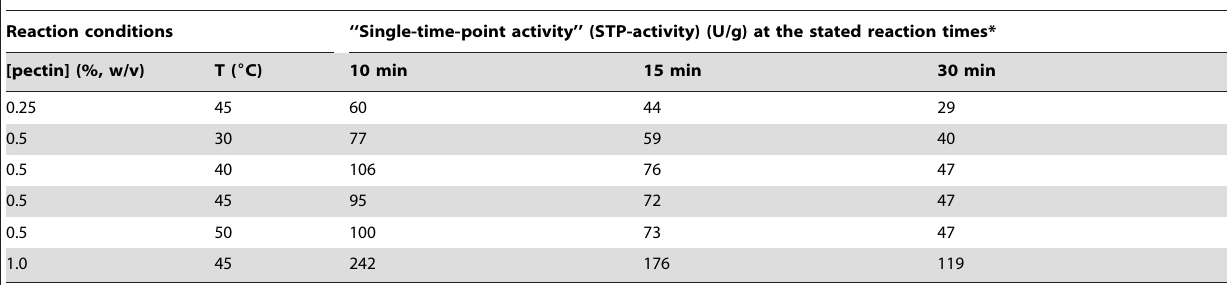
Table 3. Single-time-point pectinase activities that would be obtained for the same enzymatic extract if incubated under different reaction conditions for different times.